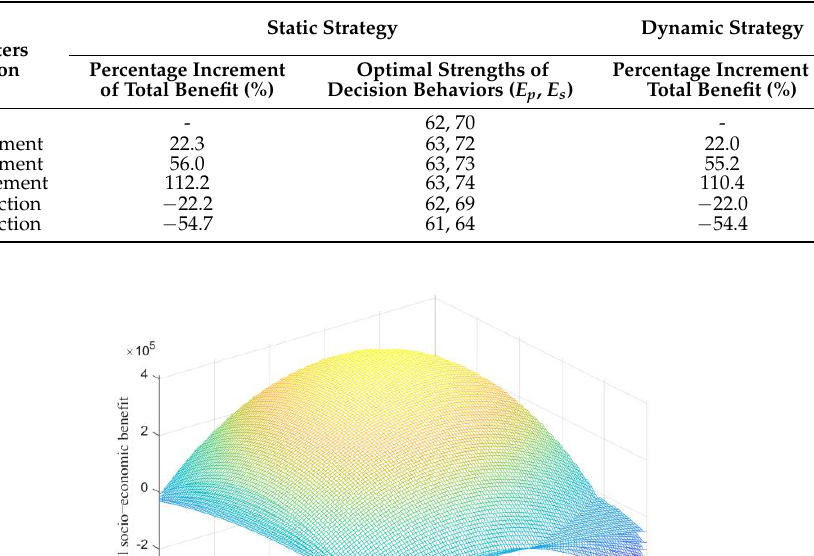
Table 2. Sensitivity analysis of model parameters for static and dynamic strategies.